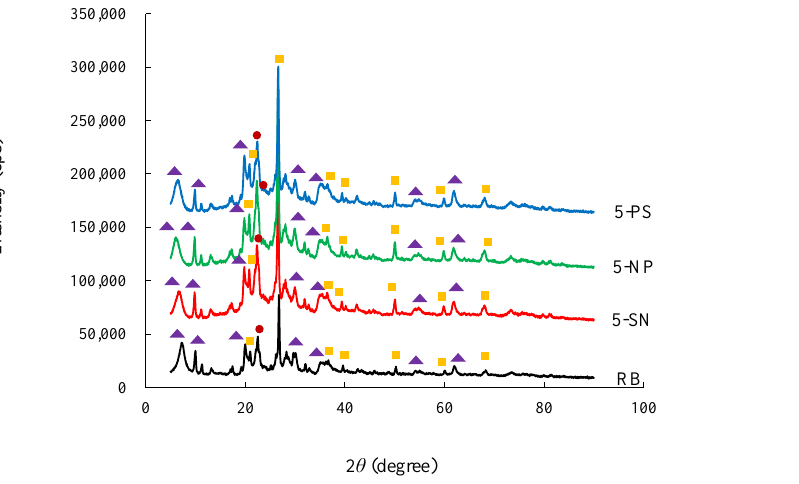
Figure 2. XRD patterns of RB, 5-SN, 5-NP, and 5-PS. ▲ Montmorillonite Na 0.3 (Al Mg) 2 Si 4 O 10 OH 2 ・ 6H 2 O, ■ Quartz SiO 2 , ● Opal CT SiO 2 .